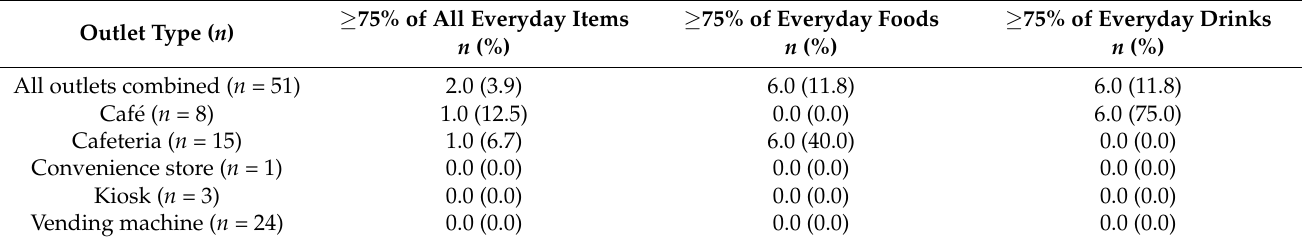
Table 2. Number and percentage of outlets meeting the Framework benchmark of ≥ 75% Everyday food and/or